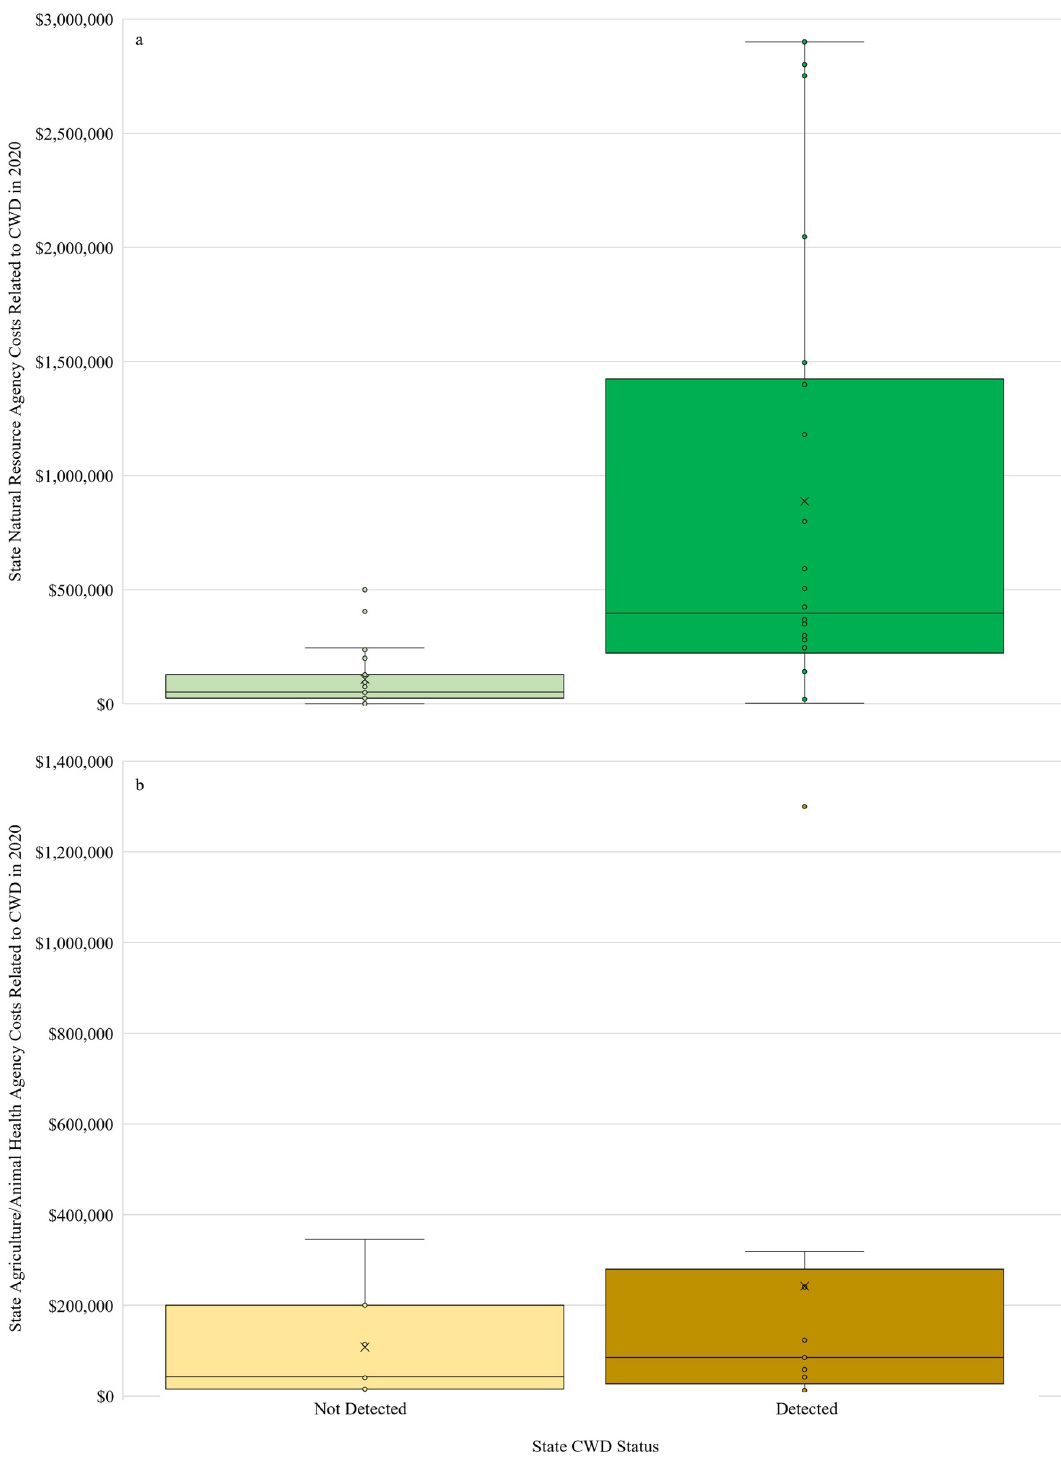
Fig 2. Distribution of reported state agency costs in fiscal year 2020 related to chronic wasting disease in states that have and have not detected the disease. Costs are displayed for (a) state natural resources agencies ( n = 49) and (b) state agriculture/animal health agencies ( n = 16) within the continental United States. The ‘x’ and horizontal lines inside each box represent the mean and median, respectively. The top and bottom of each box represent the median of the 3 rd and 1 st quartiles, respectively. ‘Whiskers’ extending above and below each box represent maximum and minimum costs not considered